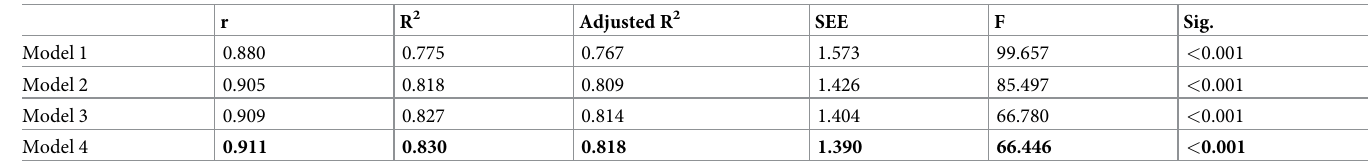
A low ASM index is essential for diagnosing sarcopenia. Among the study population, eight men and 13 women met the low ASM index criteria and were classified into the low ASM group. The low ASM group was older than the normal ASM group in men; however, no differ- ence in age was observed between the two groups in women. Both men and women in the low ASM group exhibited weaker handgrip strength. Additionally, the low ASM group had a lower MT of the BB, TB, and RF muscles in men and the BB and TB muscles in women. However, there were no significant differences in the EI of any muscle between the two groups, except for the BF muscle in men. The clinical characteristics of the normal and low ASM groups are summarized in Table 6. Table 3. Regression models for predicting appendicular skeletal muscle mass in the men group. r R 2 SEE